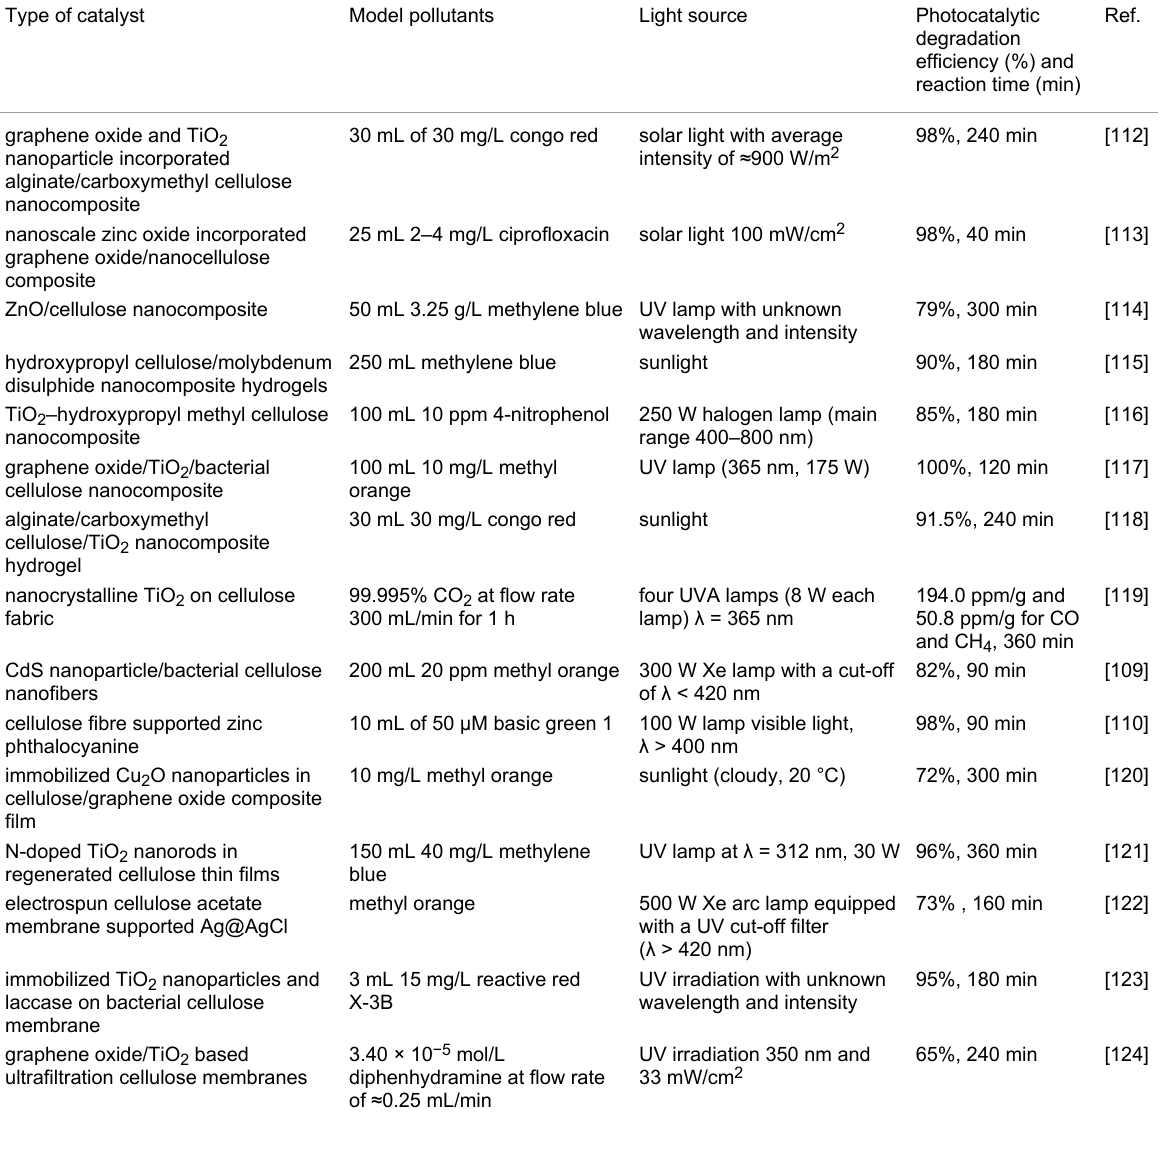
Table 2: Application of nanostructured cellulose-based hybrid photocatalysts in photocatalytic degradation of various types of organic pollutants. Type of catalyst